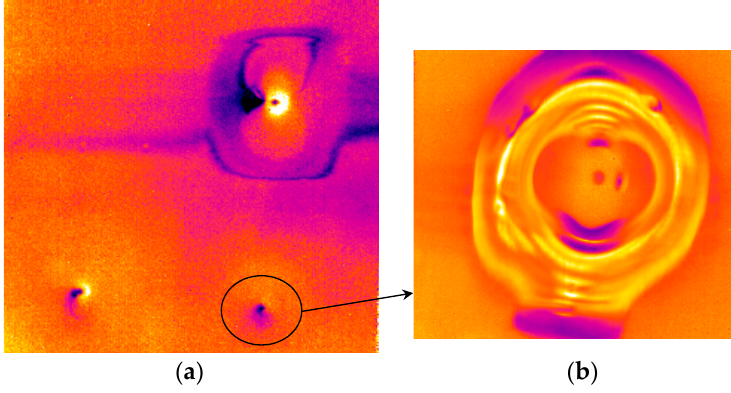
Figure 11. Impact damage of a Glare panel; phase images taken with SC3000 camera. ( a ) phase image of a large panel (500 × 500 mm 2 ); ( b ) close-up view.